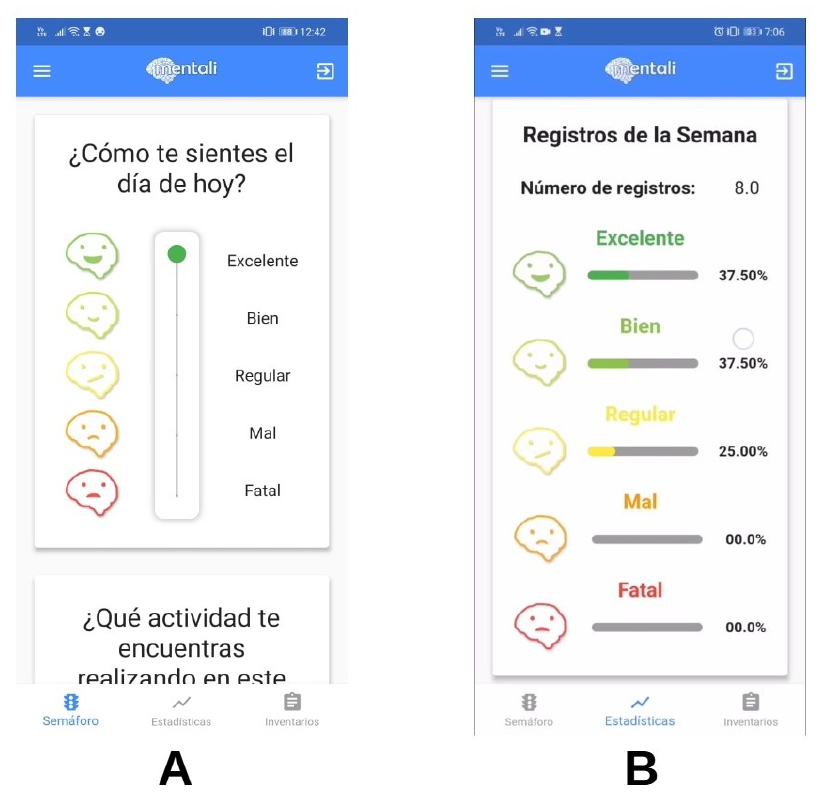
Figure 10. Mood log ( A ) and statistics ( B )